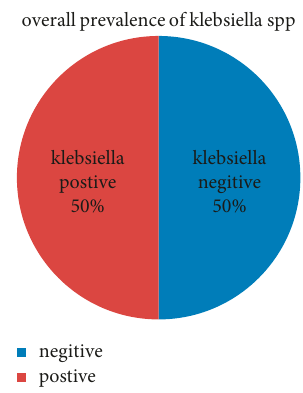
Figure 2: Overall prevalence of Klebsiella